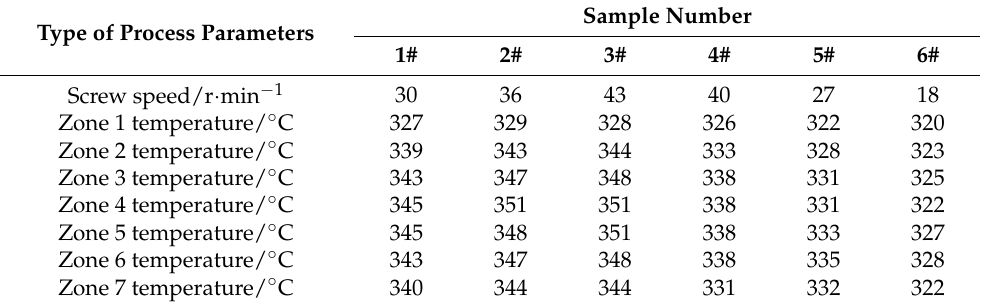
Table 2. Main process parameters of the wire extrusion process.